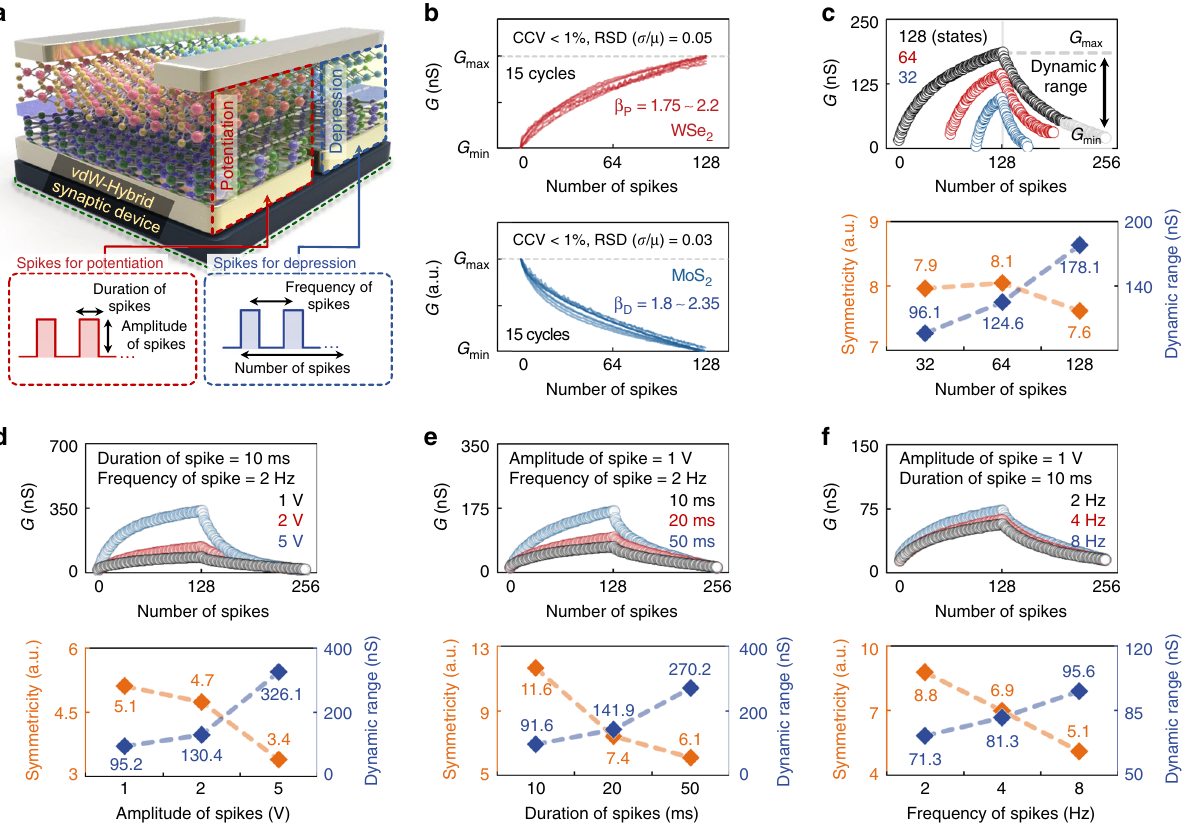
Fig. 3 Characteristics of the vdW-hybrid synaptic device with respect to various spike conditions. a Synaptic device schematics including explanation on spike condition. b LTP and LTD curves for 15 cycles and evaluated CCV and RSD ( σ / μ ) values for the potentiation and depression channels. c – f Extracted symmetricity and dynamic range from the LTP/LTD curves measured under various spike conditions, such as the number of spikes (32 – 128) ( c ), the amplitude of spikes (1 – 5 V) ( d ), the duration of spikes (10 – 50 ms) ( e ), and the frequency of spikes (2 – 8 Hz) ( f